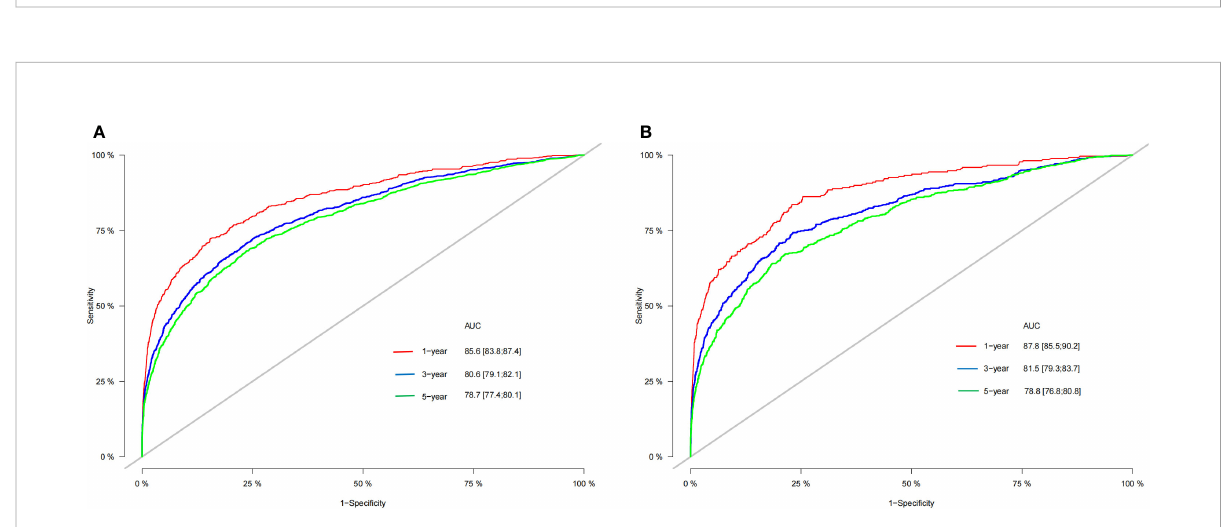
FIGURE 3 The AUC for OS of 1-, 3- and 5-year of training cohort (A) and validation cohort (B)